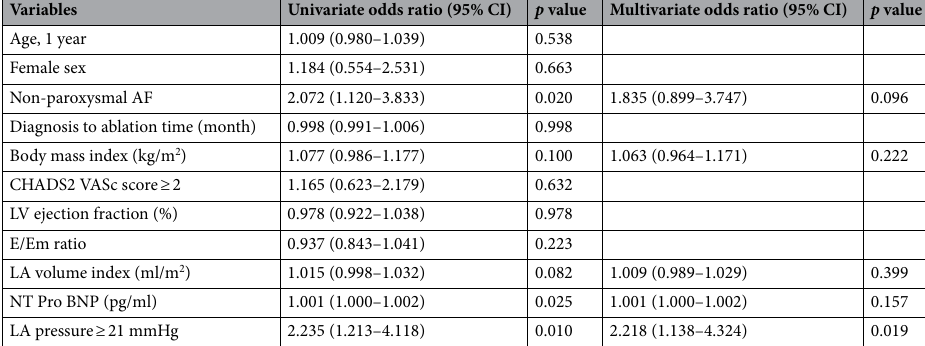
Table 2. Univariate and multivariate analysis (Logistic regression) showing odds ratio to predict E-LGE (LGE ≥ 20%). AF atrial fibrillation, LV left ventricular, LA left atrial, NT Pro BNP N terminal brain natriuretic